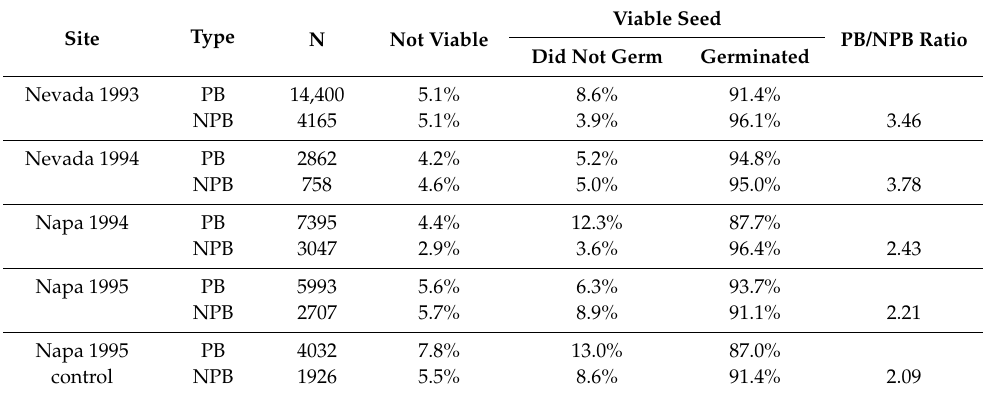
Results of germination tests of Centaurea solstitialis seed from two field sites for 1993–1995. PB = pappus bearing seed; NPB = non-pappus bearing seed; N = total seed tested; Not Viable = proportion of total seed determined upon dissection to be empty or partially filled. Viable seed is the total seed tested minus the number of seed not